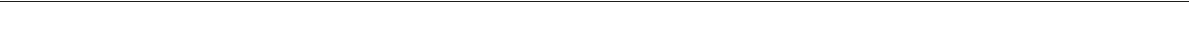
Fig. 1 The HaloTag-LC3 autophagosome completion assay distinguishes unclosed and closed autophagosomal membranes. a Schematic strategy of the HT-LC3 autophagosome completion assay. The assay is performed by the following procedures: step 1, after the induction of autophagy, HT-LC3- expressing cells are treated with cholesterol-complexing agents including recombinant perfringolysin (rPFO/XF-MPM) or digitonin to permeabilize the plasma membrane (PM) and release HT-LC3-I from the cytosol; step 2, cells are incubated with a saturating dose of membrane-impermeable HT ligand (MIL) to stain membrane-bound HT-LC3-II that is accessible to the cytosol (MIL also diffuses into nucleus and stains nuclear LC3); step 3, cells are incubated with membrane-permeable HT ligand (MPL) to stain LC3-II that is sequestered within membranes. b – j HT-LC3 U-2 OS cells were incubated in starvation medium (SM) or control complete medium (CM) in the presence or absence of 100 nM BafA1 for 4 h ( b – g ) or starved for 3 h ( h – j ) and subjected to the HT-LC3 autophagosome completion assay followed by confocal microscopy ( b – g ) and 3D-deconvolution fl uorescence microscopy ( h – j ). LC3 signals on the phagophore or the outer autophagosomal membrane, and in the autophagosome lumen were stained using Alexa Fluor 488 (AF488)- conjugated MIL and tetramethylrhodamine (TMR)-conjugated MPL, respectively. Magni fi ed images of the boxed area in ( b ) and arrow-indicated areas in ( c ) are shown in ( c ) and ( d – g ), respectively. In ( h – j ), xz and yz images at the dash-lined area in Supplementary Fig. 1c are shown to the right and bottom, respectively; arrows, white arrowheads and blue arrowheads indicate MIL + MPL − , MIL + MPL + , and MIL − MPL + structures, respectively. The scale bars represent 10 μ m and 1 μ m in ( b ) and ( c – j ), respectively. ( k ) The cytoplasmic fl uorescence intensities of MIL and MPL in each cell in ( b ) were quanti fi ed and normalized to the respective mean fl uorescence intensities of the cells starved in the presence of BafA1 ( n > 100). Data shown are representative of three independent experiments. Statistical signi fi cance was determined by one-way ANOVA followed by Tukey ’ s multiple comparison test. All values are mean ± SD. ns not signi fi cant; **** p ≤